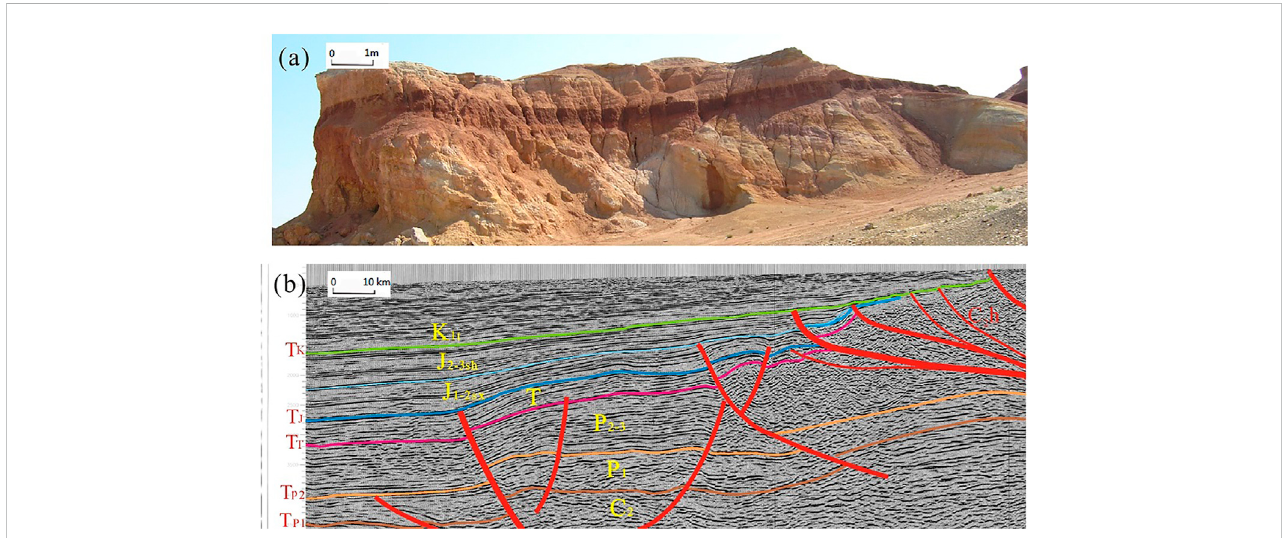
FIGURE 3 Stratigraphic unconformity in northern Junggar Basin. (A) The outcrop pro fi le shows the angular unconformity between the lower Cretaceous and the upper Jurassic. (B) Unconformity in the study area shown by seismic pro fi le.